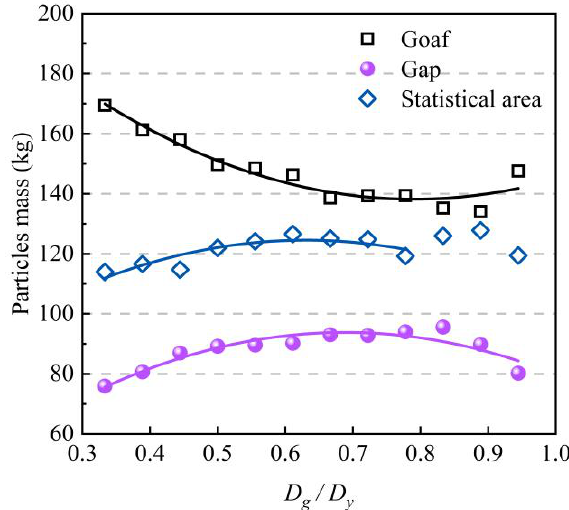
Figure 16. The distribution of particles versus barrel diameter in pushing mode ( D y = 900 mm).